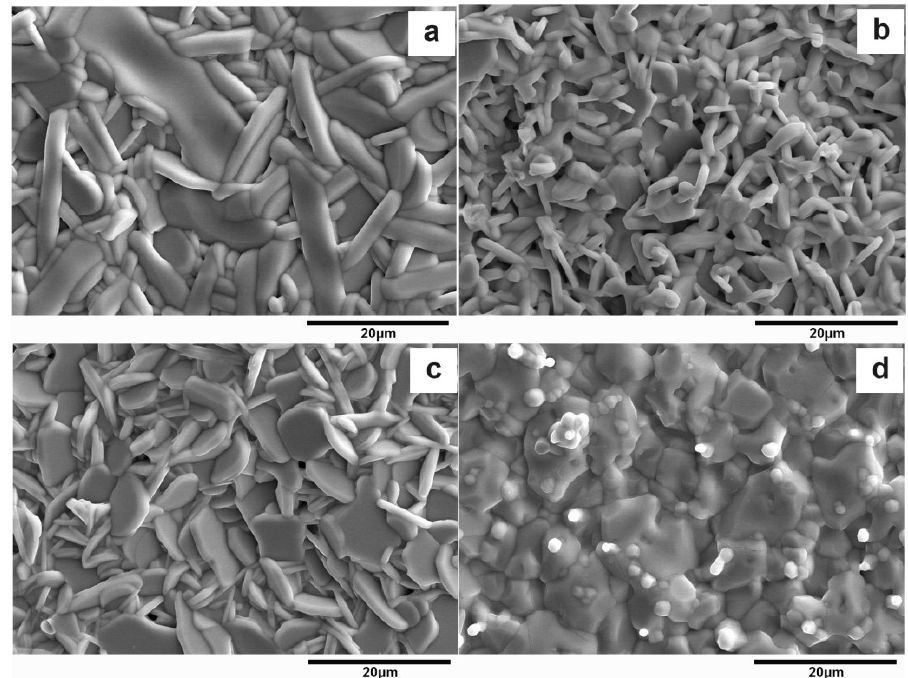
Figure 3. SEM morphology of La ( d ) x =